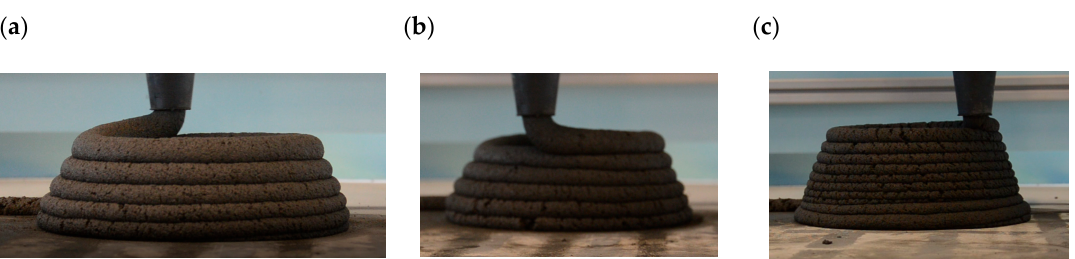
Figure 16. Collapse during printing for specimens of mix B640 / SF / FA. ( a ) t b = 15 min; t p = 10 s; ( b ) t b = 30 min; t p = 15 s; ( c ) t b = 45 min; t p = 20 s.